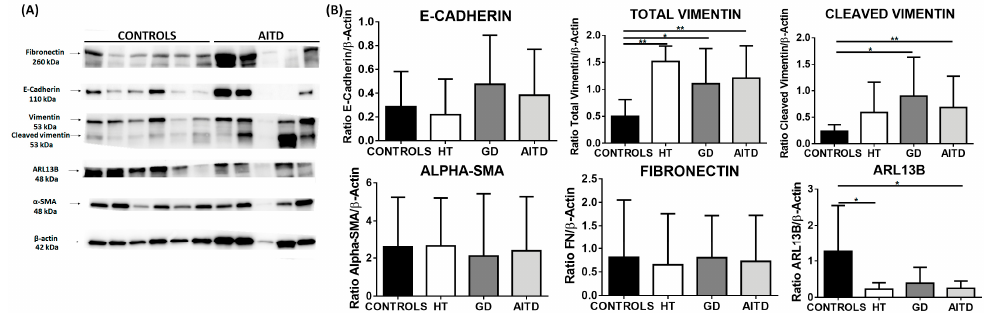
Figure 3. Western blot analysis of EMT markers in thyroid tissue from controls, HT, and GD patients. ( A ) Western blot analysis of E-cadherin, vimentin, fibronectin, α -SMA, and Arl13b. ( B ) Protein quantitation of the EMT markers indicated above. Data correspond to the arithmetic mean ± SD. * p < 0.05; ** p < 0.01.